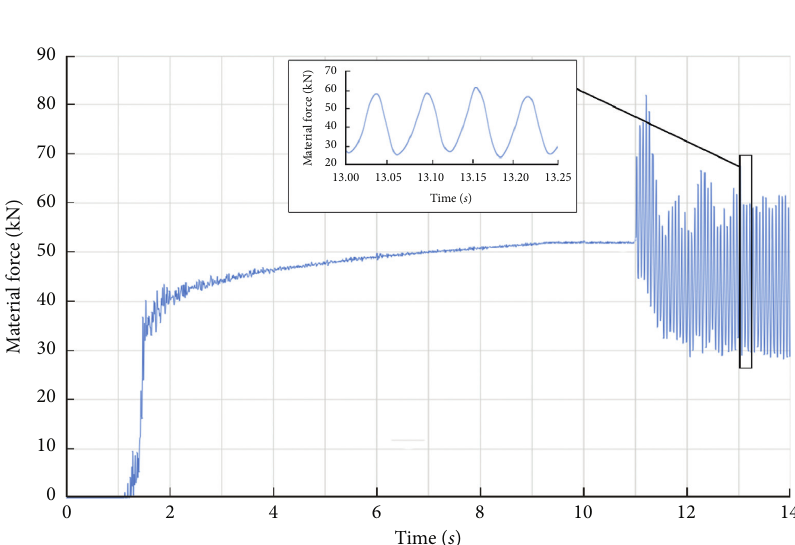
Figure 2: Time-domain curve of materials force on vibrating feeder surface.